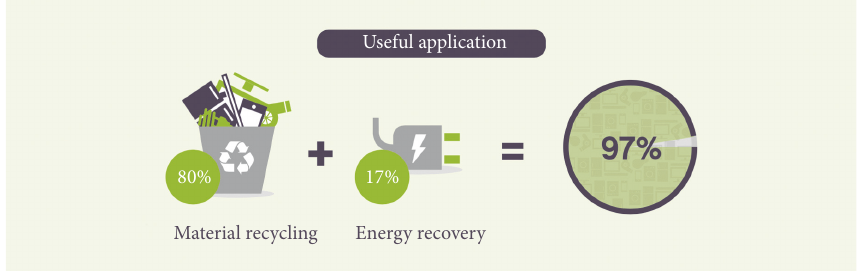
Figure 1: In 2016, e-waste collection in the Netherlands led to 80% material recycling and 17% energy recovery.